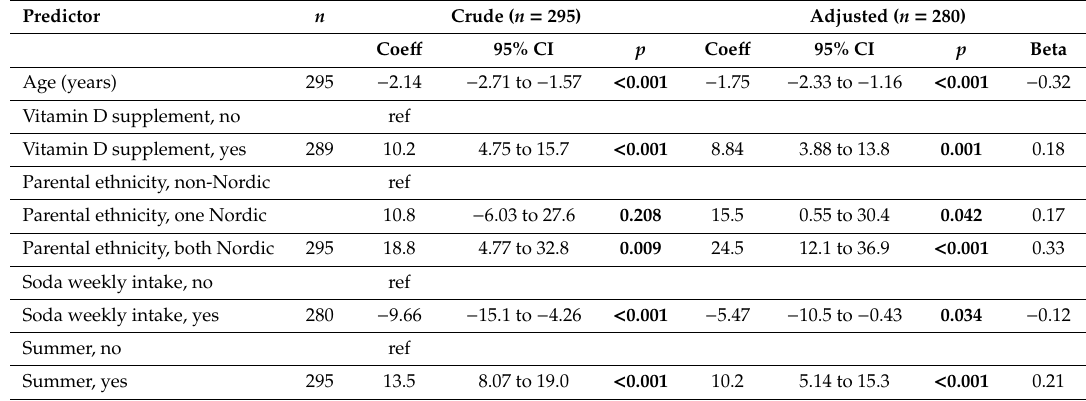
Figure 2. Plasma 25(OH)D levels and age. Predicted mean and 95% CI in relation to age in years. Table 4. Determinants of 25(OH)D levels in Norwegian